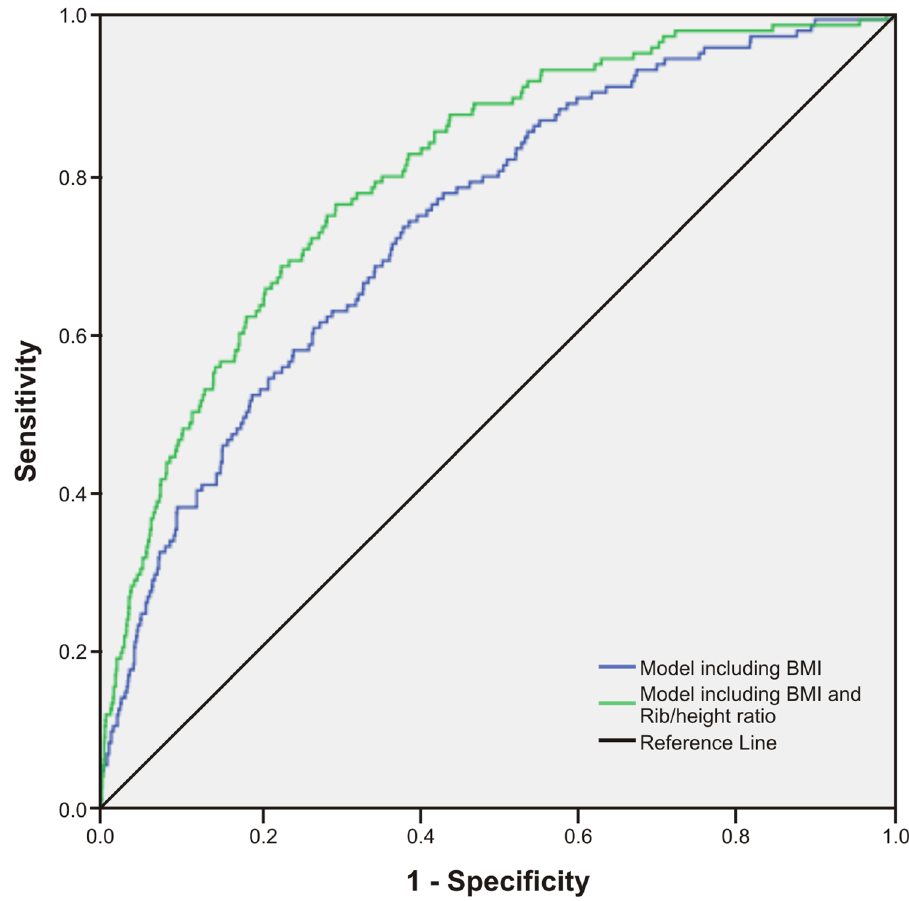
Fig 8. Receiver operating characteristic curves for prediction models to discriminate subjects with type 2 diabetes. Figures show ROC curves for a model including BMI and a model including BMI and Rib/ height ratio. All models include age and